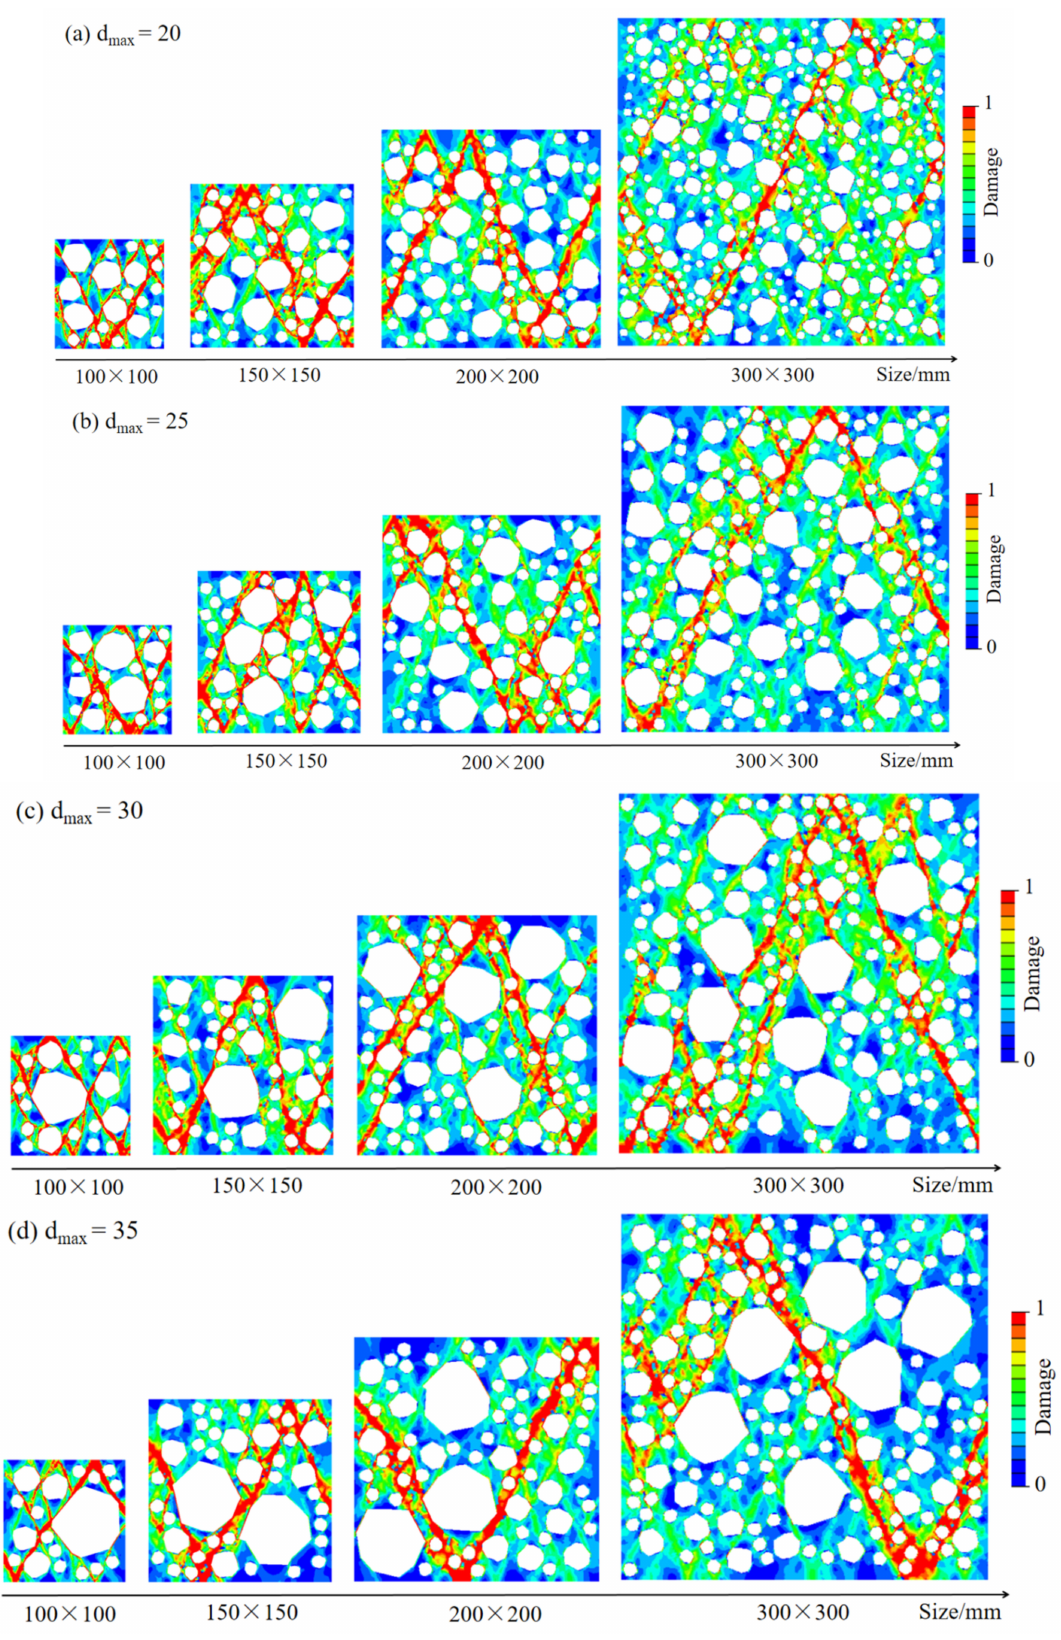
Figure 18. The compression failure modes of RAC under different